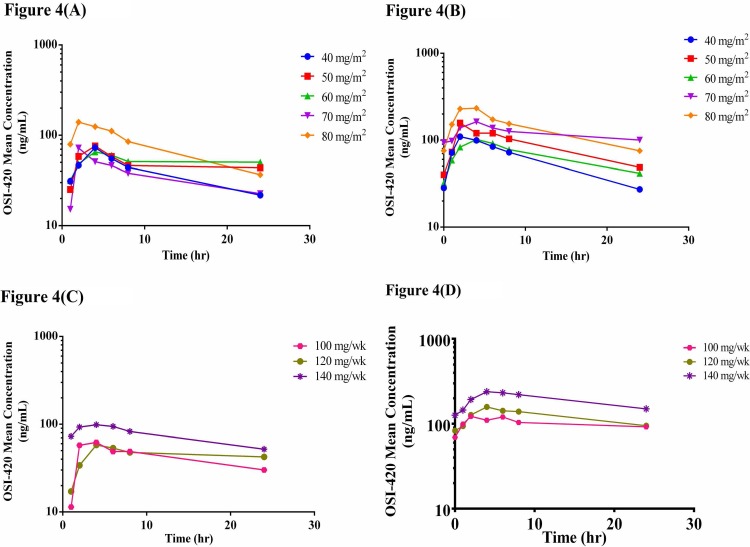
Mean plasma concentration-time curves of OSI-420 (A) on Day 3 after initial oral dose with CSV dosing regimen of vinorelbine, (B) on Day 10 at the steady state after oral dose with CSV dosing regimen of vinorelbine, (C) on Day 3 after initial oral dose with MSV dosing regimen of vinorelbine and (D) on Day 10 at the steady state after oral dose with MSV dosing regimen of vinorelbine.